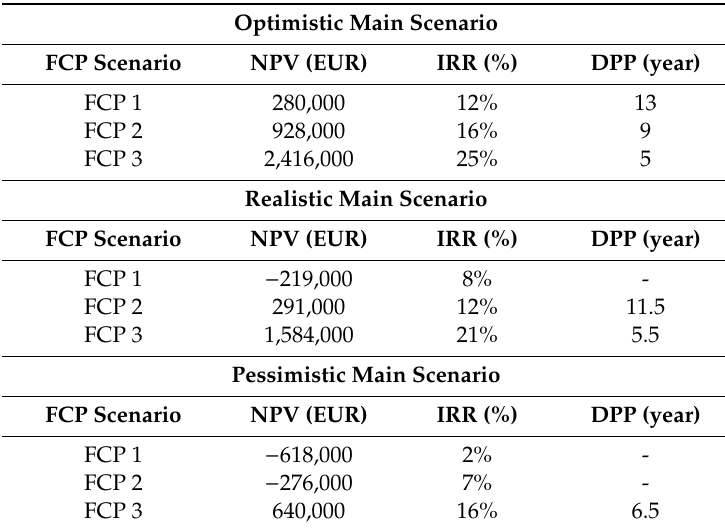
Table 10. Economic results of the proposed scenarios. NPV: net present currency, IRR: internal rate of return, and DPP: discounted payback